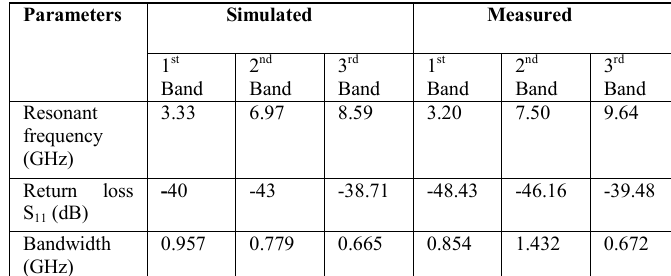
Table 2: Comparison between Simulated and Measured Results